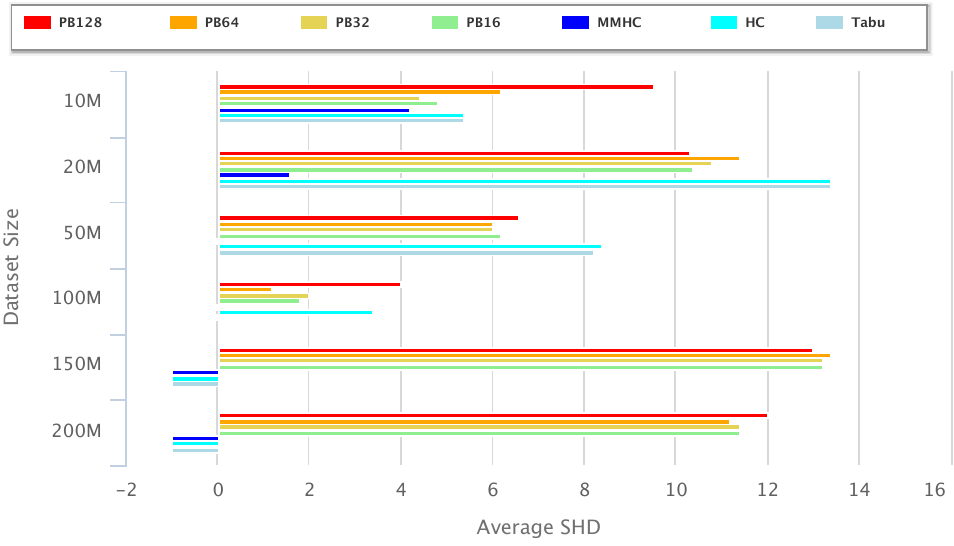
Figure 13. Alarm Dataset Accuracy Results. Negative values indicate that the algorithm was unsuccessful in learning a network for the dataset.